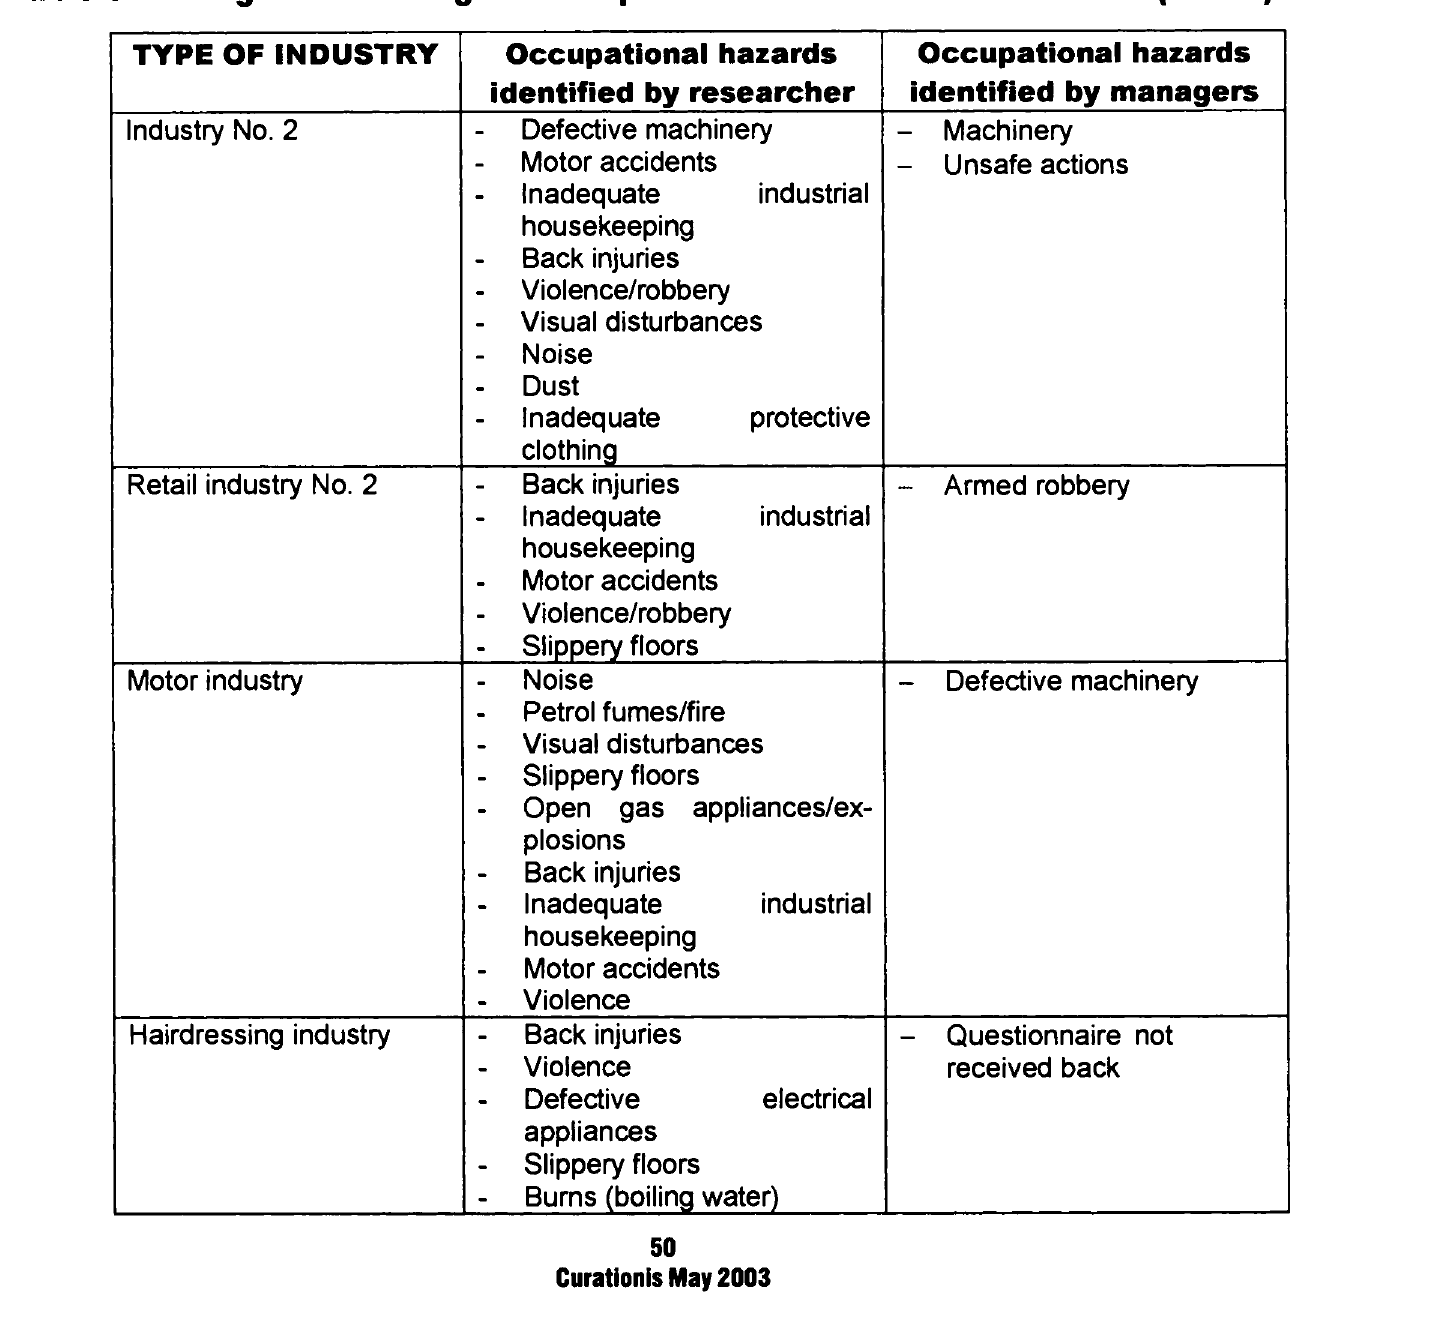
Table 3: Managers’ knowledge of occupational hazards in the industries (N=14) TYPE OF